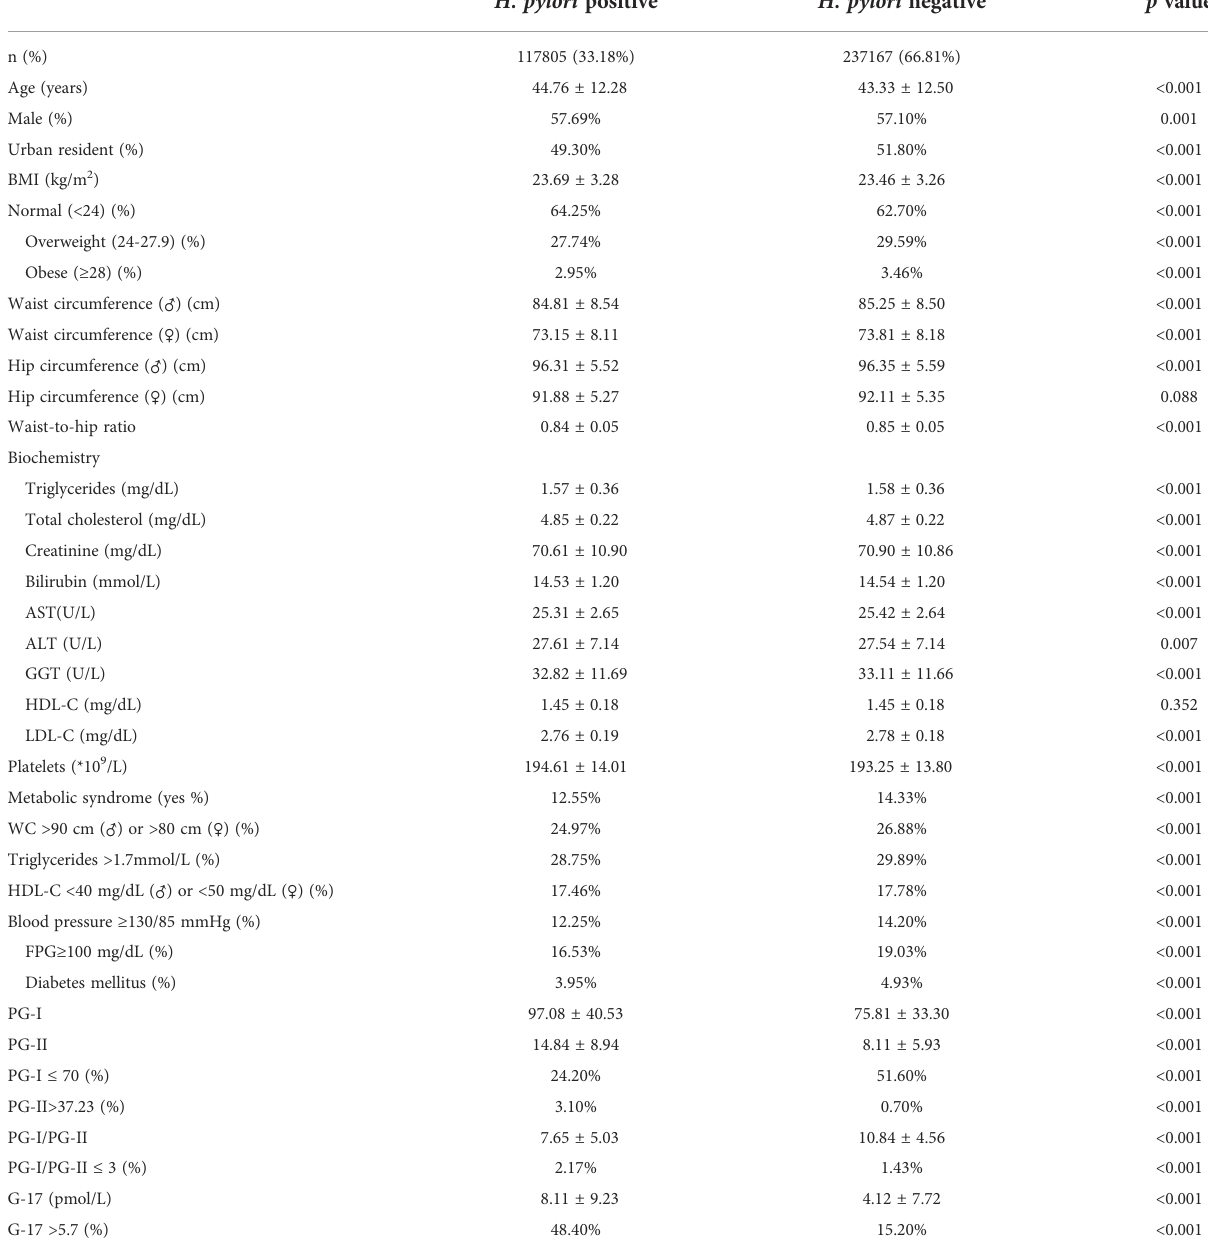
TABLE 1 Characteristics of subjects in H. pylori positive and negative